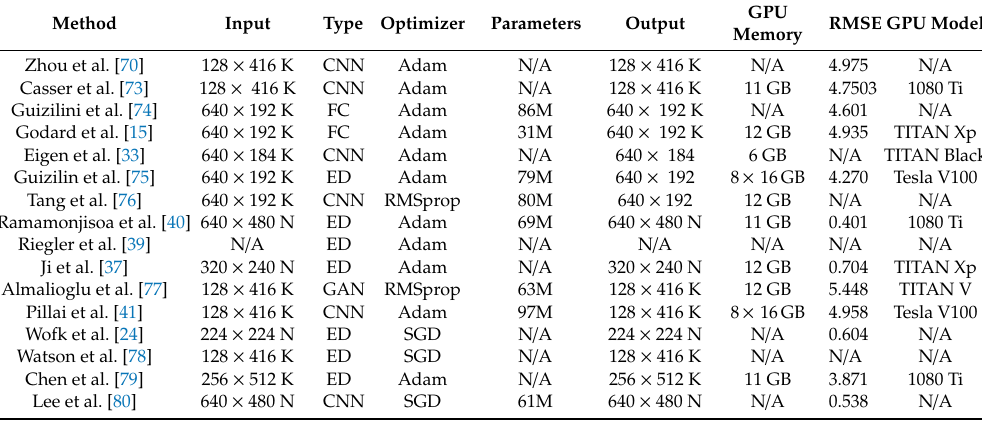
Table A1. Properties of the low-accuracy methods trained on either KITTI or NYU-v2 datasets. (FC: fully convolutional, ED: encoder-decoder, AD: auto-decoder, K: trained on KITTI dataset, N: trained on NYU-v2 dataset and CNN: convolutional neural